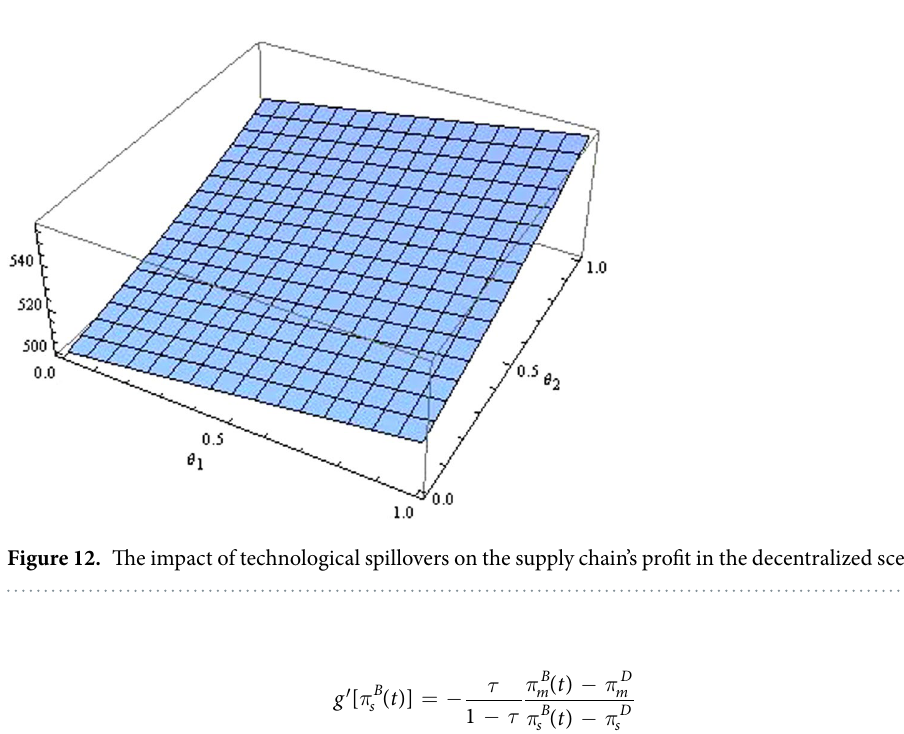
Figure 11. The impact of technological spillovers on the supply chain’s profit in the centralized